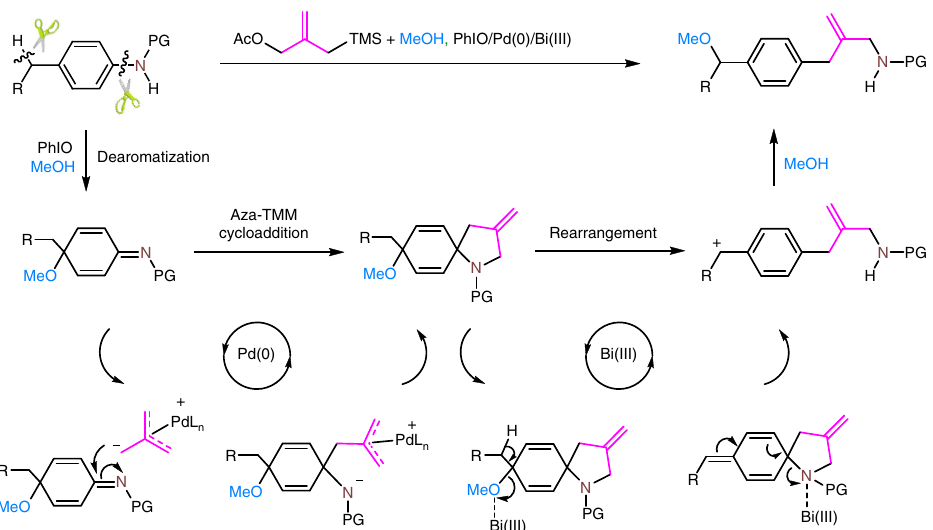
Fig. 4 Plausible reaction pathway. The transformation might proceed via a dearomatization of anilines, an aza-TMM cycloaddition, followed by a subsequent rearomatizing rearrangement and trapping the benzylic carbon cation by nucleophilic attack. PG protecting group. Green scissors mean the bonds there will be cut